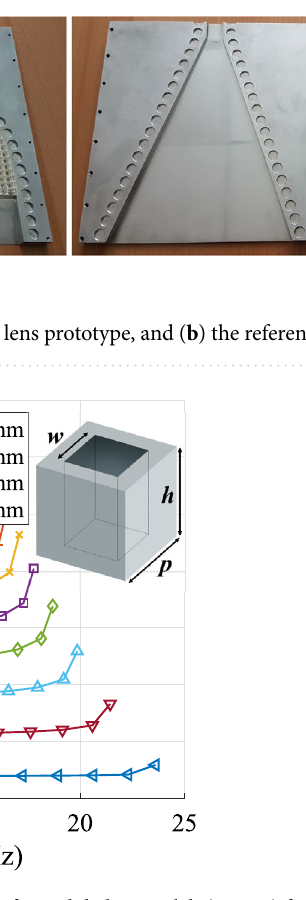
Figure 6. Equivalent refractive index of the perforated dielectric slab ( ε r = 3 ) for various hole sizes ( p = 6 mm and h = 2